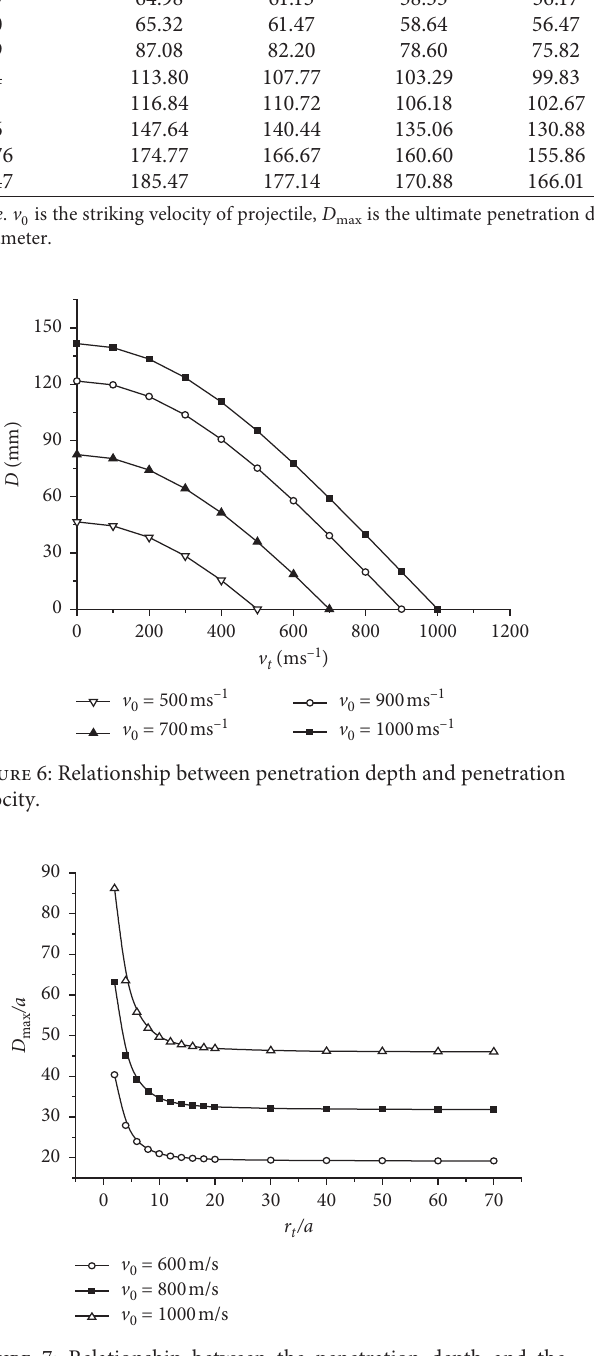
Figure 7: Relationship between the penetration depth and the target